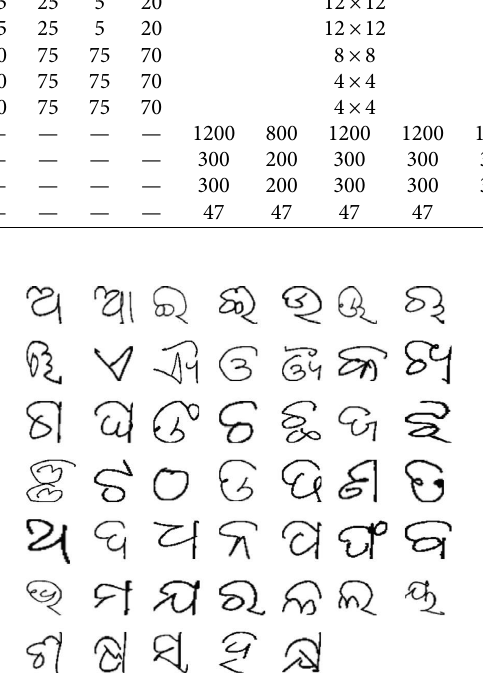
Figure 1: Sample characters of NITROHCS v1.0 database.